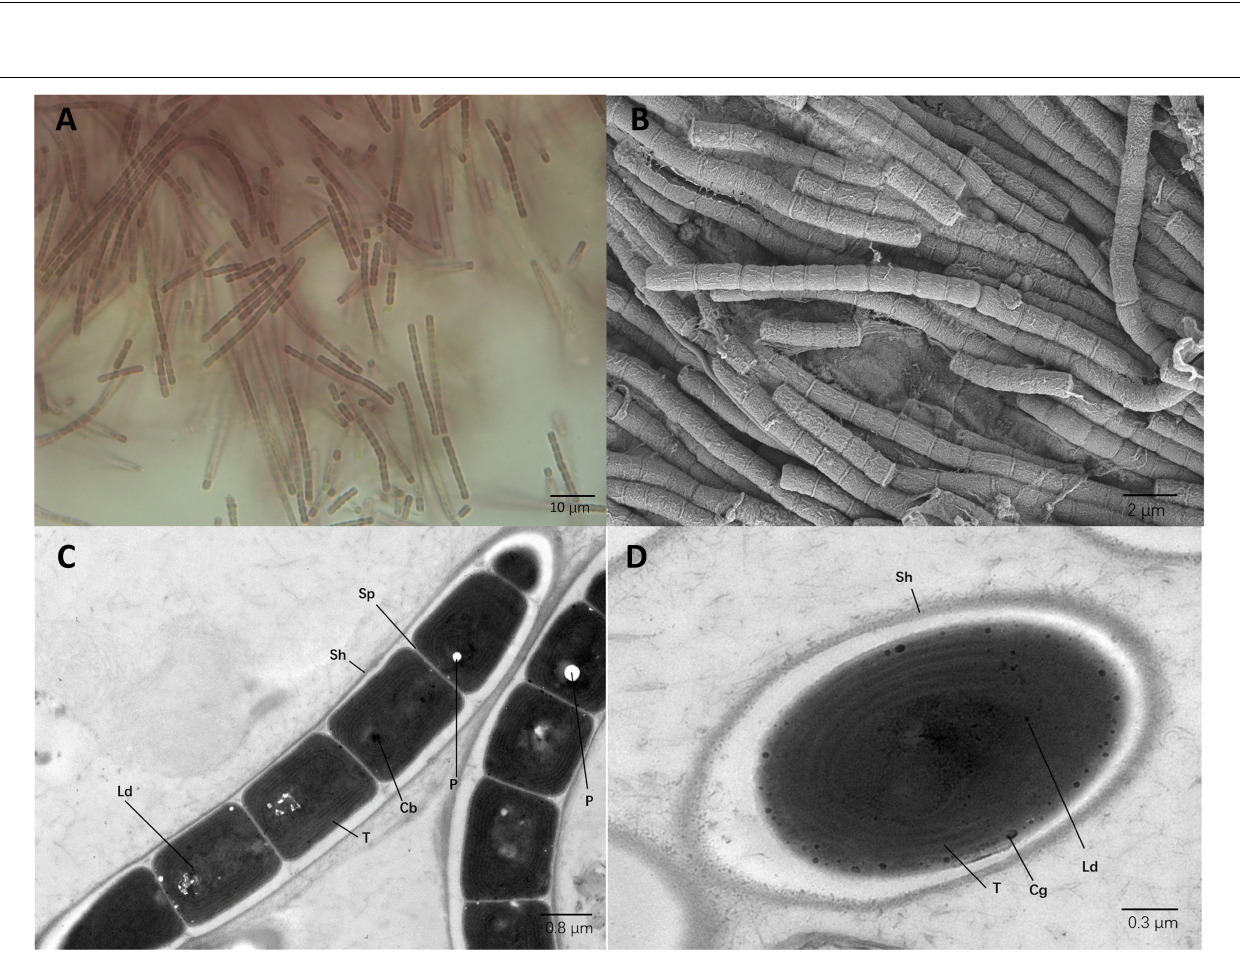
Frontiers in Microbiology |